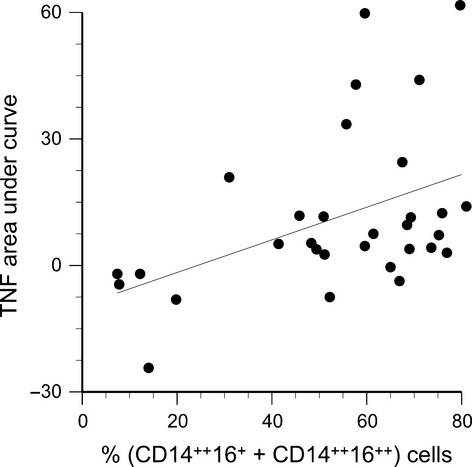
Leptin‐induced TNFα secretion (expressed as area under curve) plotted as function of the percentage of CD14++16+ and CD14++16++ monocytes in the blood sample (R = 0.44, P = 0.01).